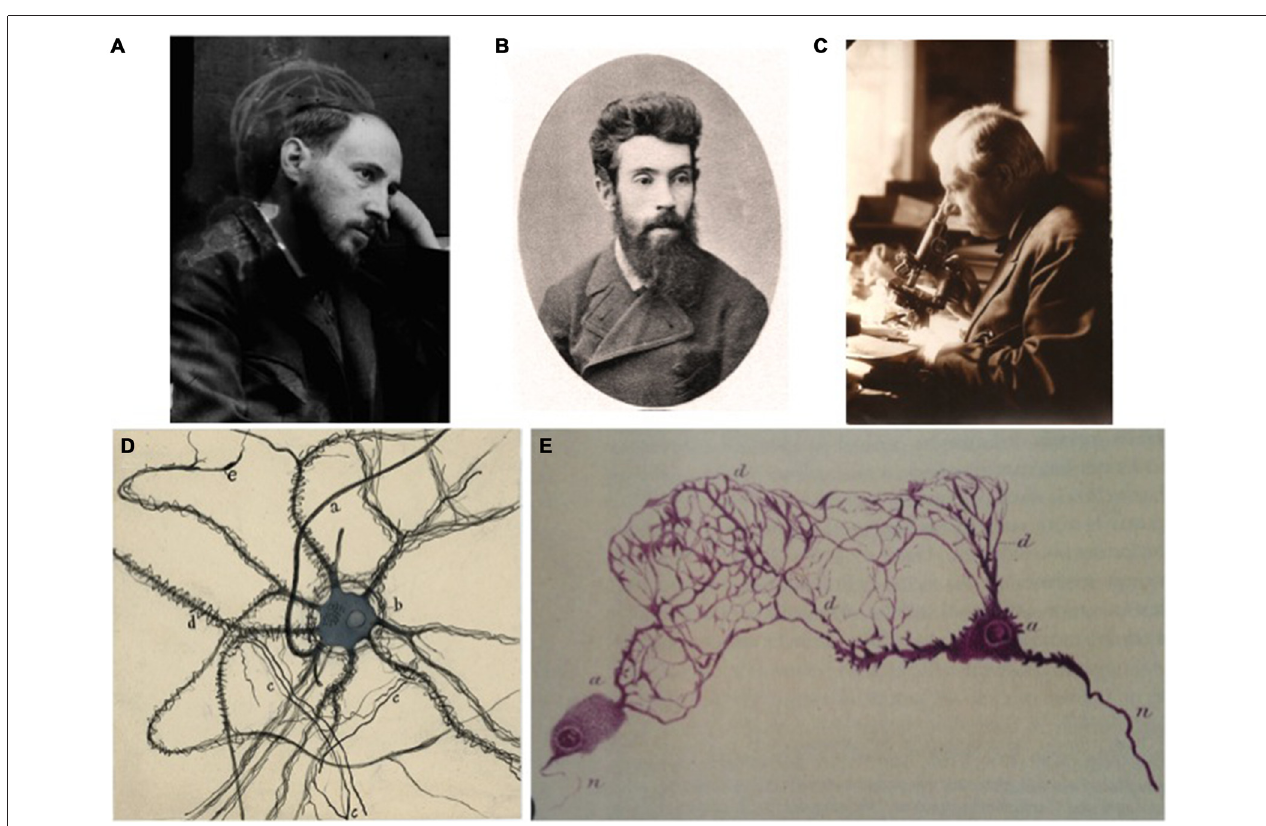
FIGURE 1 | A tribute to some pioneers of the study of the autonomic nervous system. (A) Photographic self-portrait of Santiago Ramón y Cajal; his profile is outlined by a chalk sketch of a human brain. (B) Portrait of the recognized Russian histologist Alexander Dogiel. (C) The Russian neuroscientist Lawrentjew looking at the microscope. (D) A detailed drawing from a sympathetic neuron by Santiago Ramón y Cajal, as a good example of the neuronist interpretation of the fine structure of the nervous system. (E) Dogiel’s interpretation of neurons from the Auerbach plexus (published in: Dogiel, 1899), a good example of reticularist vision of the organization nervous system (A–D) are part of Archive Fernando de